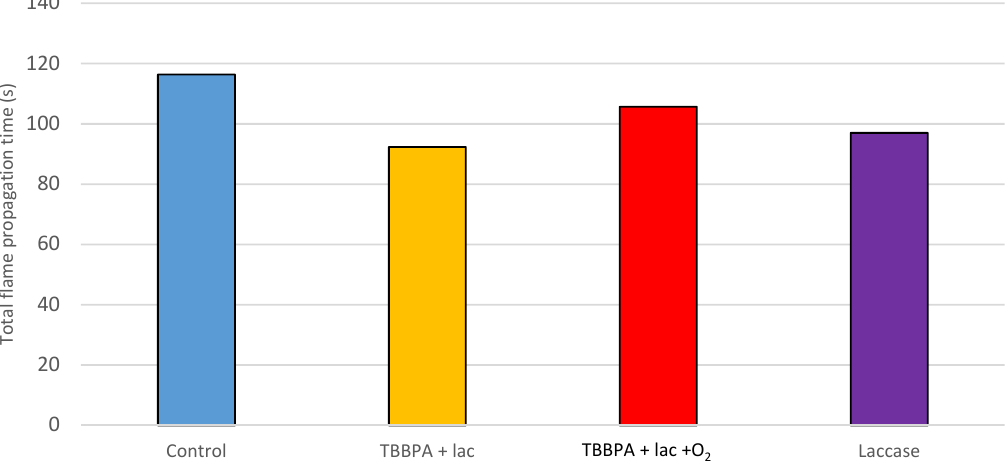
Figure 5. Total time of flame propagation along the 3 flame exposition times. Control: water impregnated only; TBBPA: treated with TBBPA alone; TBBPA/Laccase: treated with TBBPA and laccase; TBBPA/Laccase/O 2 : treated with Laccase and O 2 ; Laccase: treated with laccase